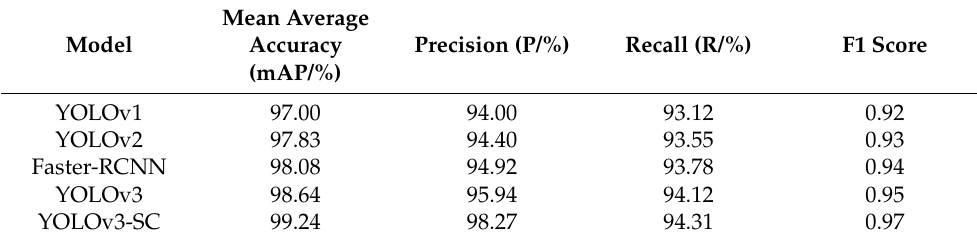
Table 2. Comparison of YOLOv3 and YOLOv3-SC. Mean Model